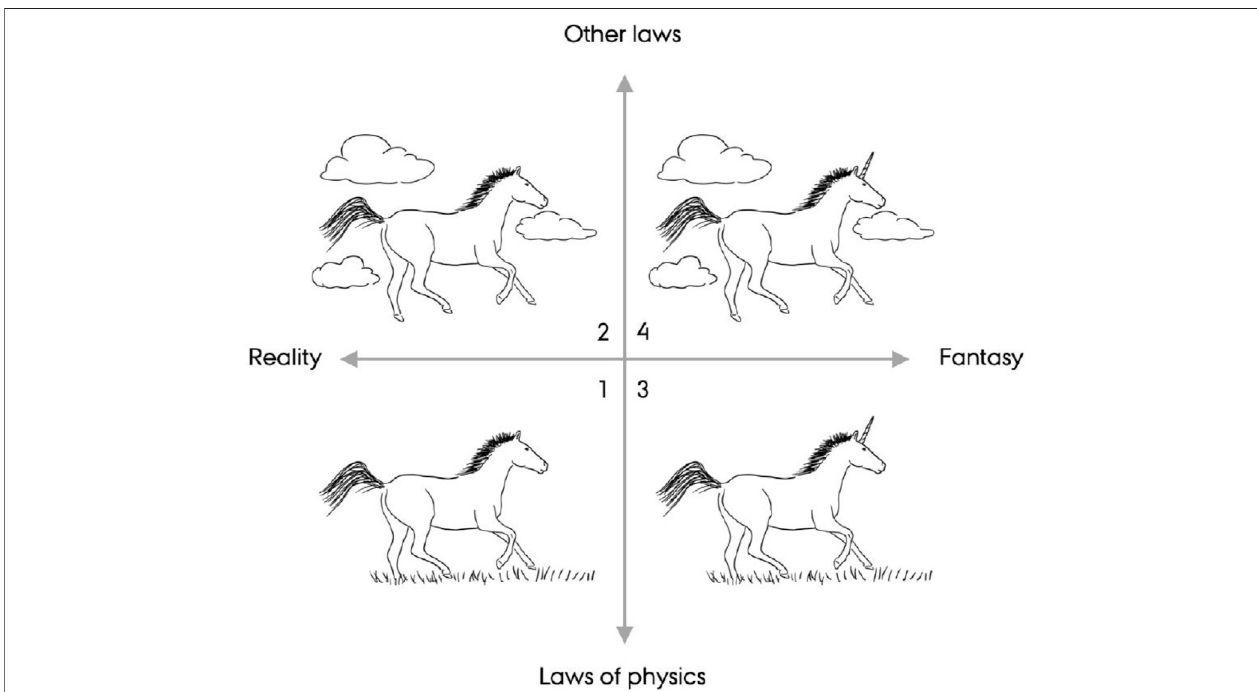
FIGURE1| Thereality-impossibilitymodel.The(1)Physicalrealityquadrantisbothrootedinrealscenariosandexperiencesfollowthelawsofphysics(ahorsethat gallops), the (2)Other reality quadrant is rooted in real scenarios and experiences do not follow the laws ofphysics(a horse that fl ies), the (3) Physical fantasy quadrant is rooted in fantasy scenarios and follows the laws of physics (a unicorn that gallops), and the (4) Other fantasy is rooted in fantasy and do not follow the laws of physics (a unicorn that fl